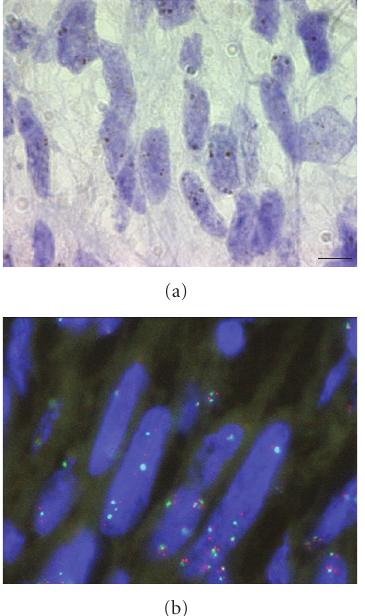
Figure 4: CISH and FISH analysis on the R84 MPNST sample. (a) The mean number of spot detected in the nuclei of 40 to 60 tumour cells in this sample stained by CISH was 3.3. (b) FISH confirmed multiple spot of EGFR (red) but revealed a polysomy of chromosome 7 (green) for this tumour. Scale bar represents 5 µ